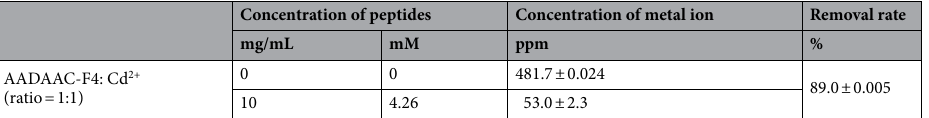
Table 5. The removal rate of Cd 2+ with the recycled AADAAC-F4 treatment. Cd 2+ bound-AADAAC-F4 was treated with 1 M of hydrochloric acid solution and then evaluated its metal binding affinity. Mean removal rate with SE were shown in the table. The peptide was dissolved in Tris–HCl buffer solution (50.0 mM Tris, 599 mM NaCl, pH 8.0). The measurements were repeated at least three times.